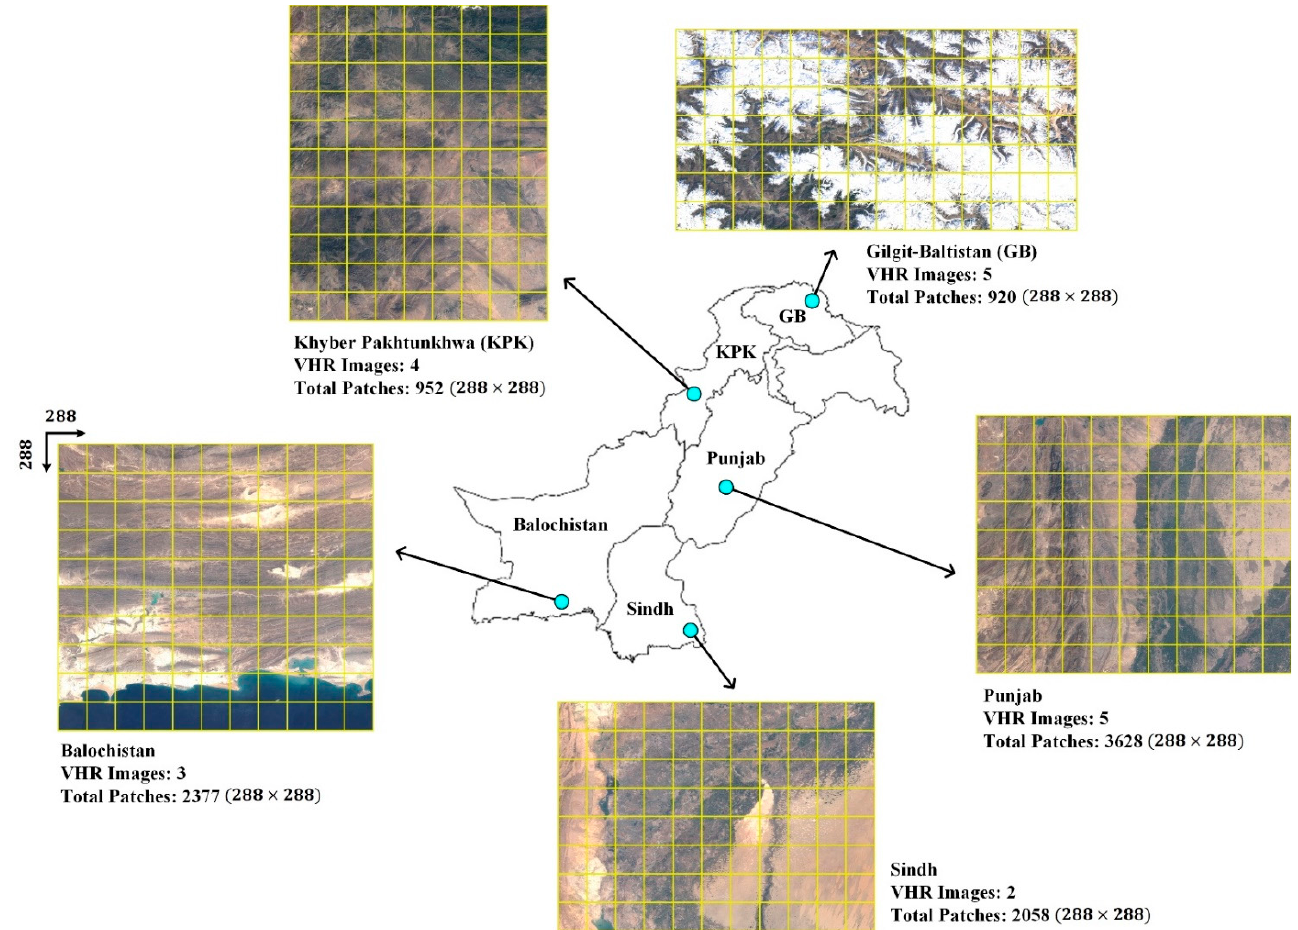
Figure 2. The specific distribution of regions in the study area of Pakistan.